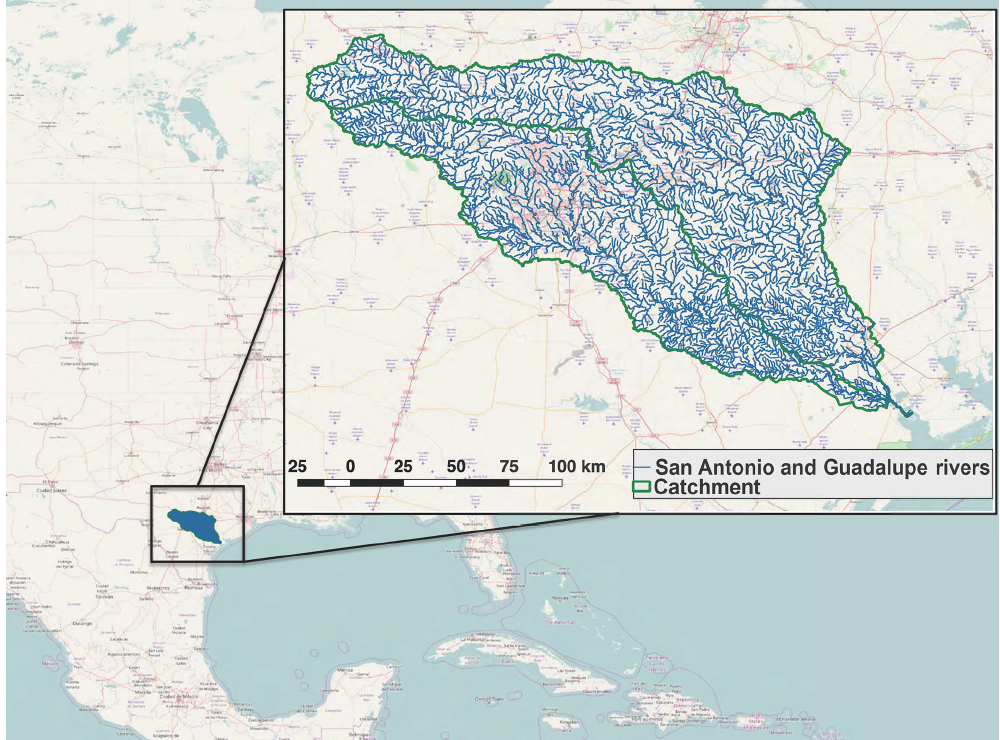
Figure 3. San Antonio and Guadalupe river network from an NHDPlus V2